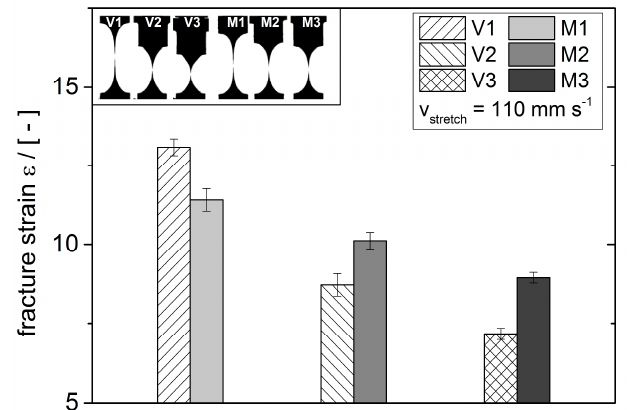
Figure 6. Fracture strain ε results obtained from sample stretching experiments measured with the capillary breakup elongation rheometer (CaBER) device at v stretch = 110 mm s − 1 stretching speed. Exemplary pictures of stretched and broken filaments for vehicles and silver pastes are shown inset. Patterned bars correspond to vehicles, filled bars represent silver pastes.